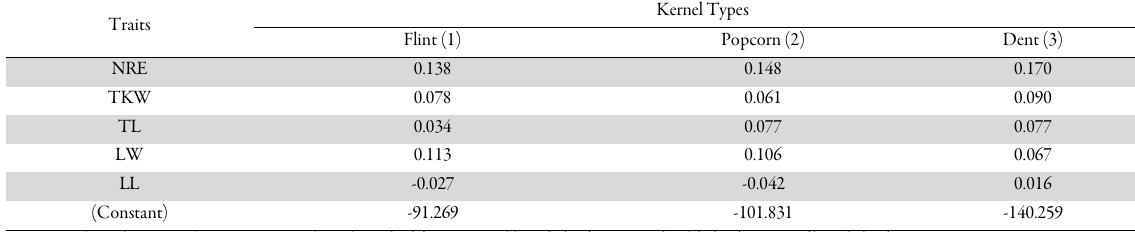
Table 4. Fisher's linear discriminant functions and classification function coefficients Traits